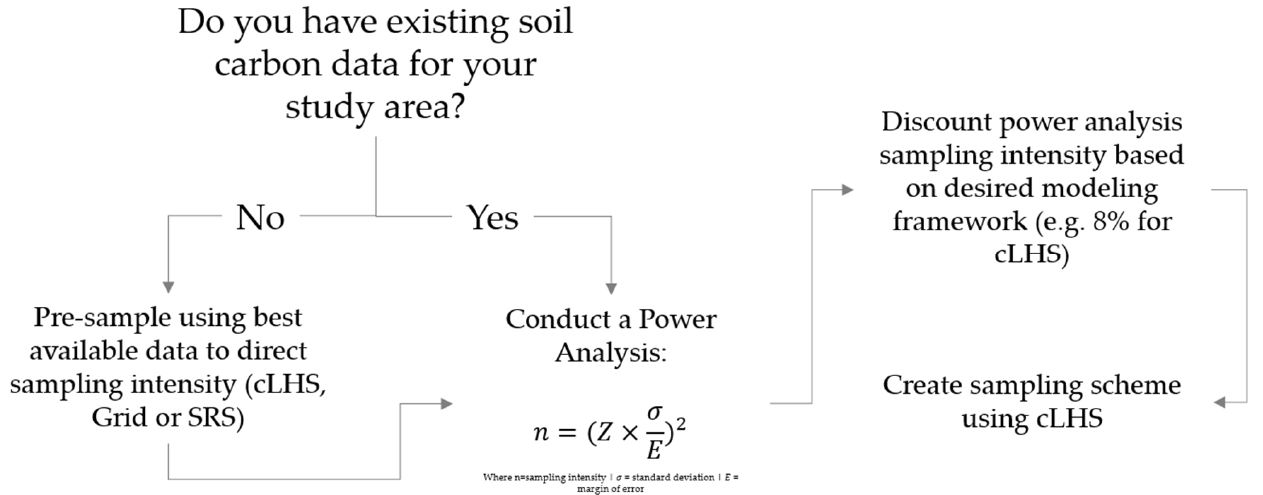
Figure 8. Framework for sampling design. Existing data may be previous soil carbon sampling on study site, on adjacent properties, or local/regional common-practice baselines based on soil type, land management, and landform characteristics.